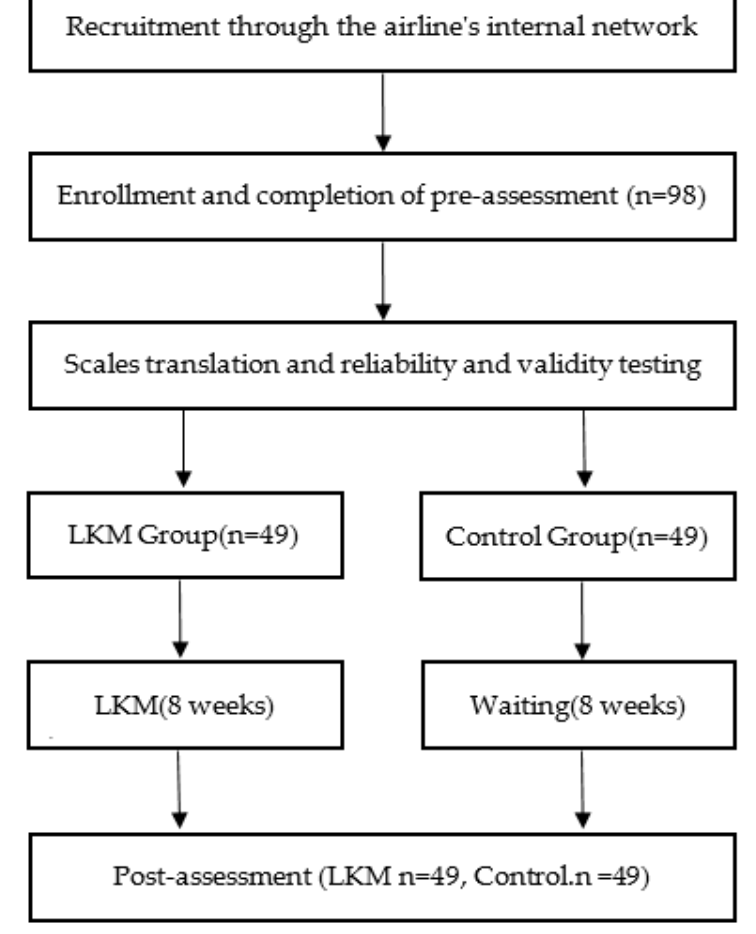
Figure 1. Procedure flow chart.